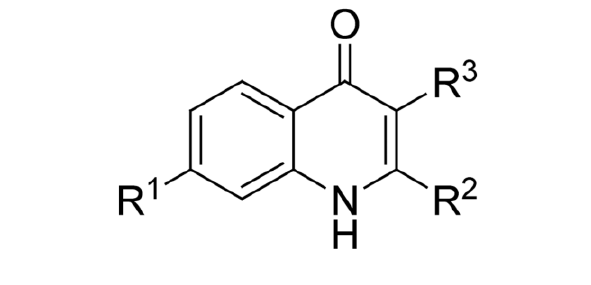
Figure 1. Molecules in this study. In all, R 1 is an H atom. In Pseudomonas quinolone signal (PQS), 2-heptyl-4-hydroxyquinoline (HHQ), 2-heptyl-3-chloro-4(1 H )-quinolone (3Cl-PQS) and 2-heptyl-3- amino-4(1 H )-quinolone (3NH 2 -PQS) R 2 is an alkyl side chain, C 7 H 15 . In C1-PQS, C3-PQS, C5-PQS, and C9-PQS R 2 is an alkyl side chain of 1, 3, 5, and 9 carbon molecules, respectively. In PQS and HHQ, R 3 is a hydroxyl group or an H atom, respectively. In 3Cl-PQS and 3NH 2 -PQS, R 3 is a chlo- rine or primary amine group, respectively.